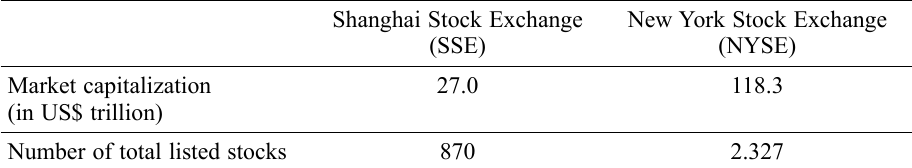
Table 1. Size and the number of stocks in the Shanghai and New York Stock Exchanges The table shows the market capitalization and the number of total listed stocks in the two Stock Exchanges, Shanghai Stock Exchange (SSE) and New York Stock Exchange (NYSE), as of De - cember 2009. The data source is World Federation Exchanges – Statistics/Monthly. The